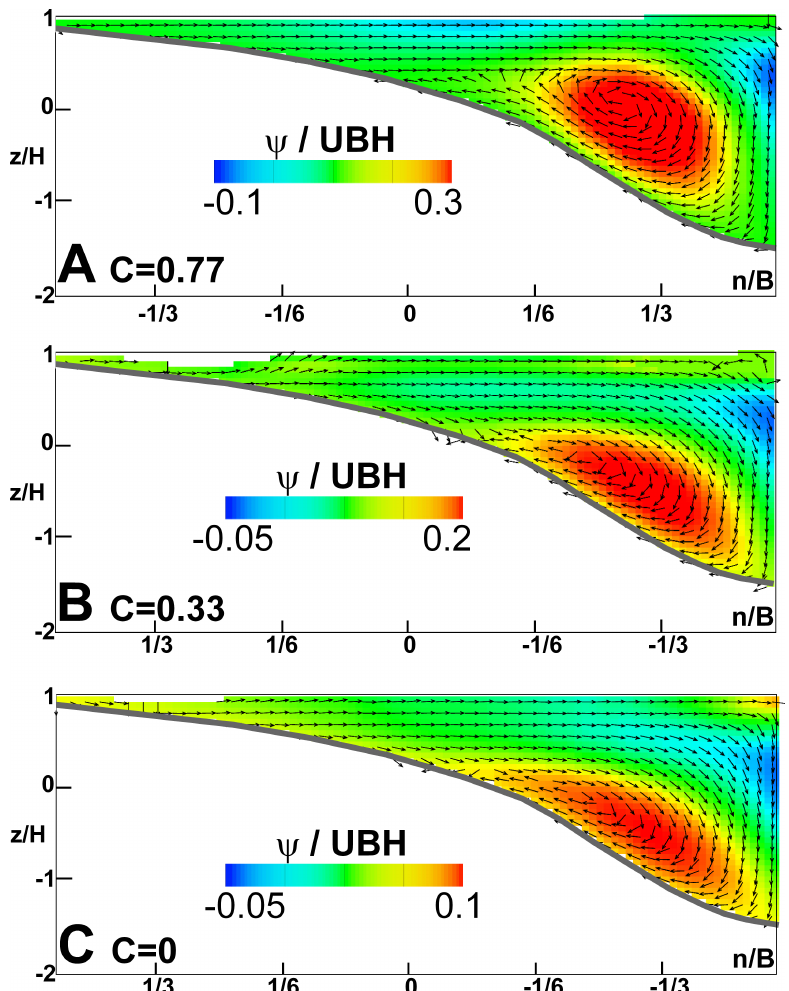
Figure 12. Transverse stream function distribution ψ / UBH reveals the secondary circulation of transverse flow cells rotating at the meander apex 1.5 s / B for channel curvature C = 0.77 ( A ), C = 0.33 ( B ), and C = 0 ( C ), with positive values representing clockwise rotation direction when facing upstream, and negative values representing counter-clockwise rotation when facing